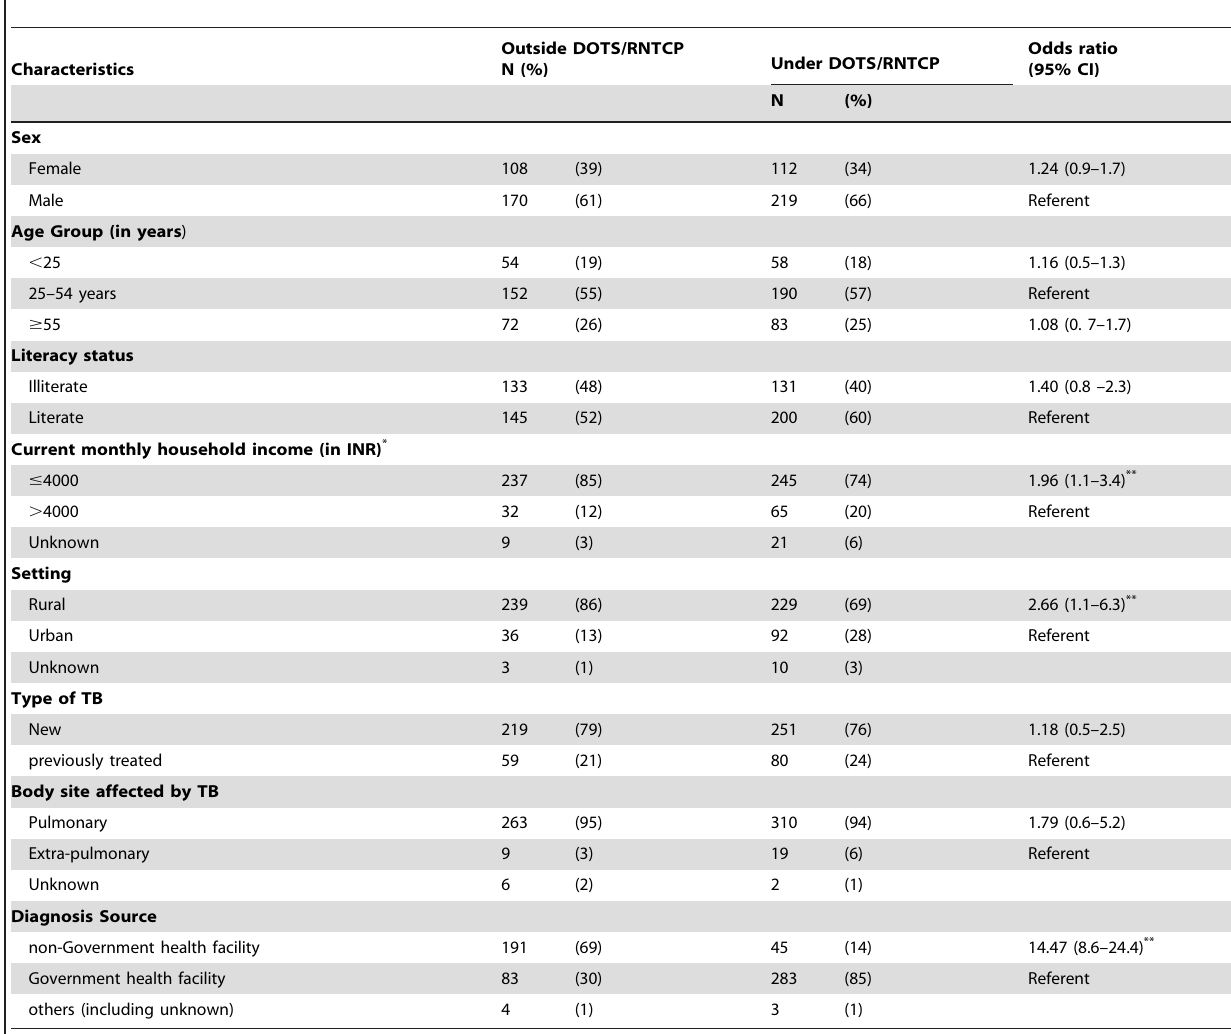
Table 3. Characteristics of self Reported TB patients (n=609) in relation to their source of TB treatment in a Community based Survey in India, 2011 (Bi-variate